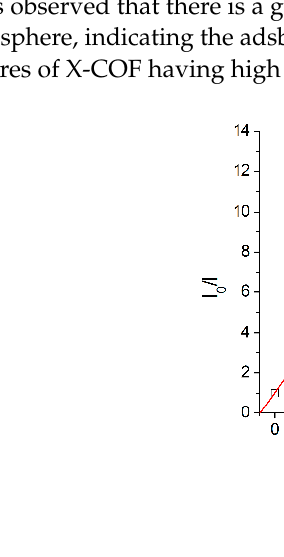
Figure 11. Emission monitoring ( a ) and Stern-Volmer plots ( b ) of CuPX-COF, X = Br, Cl.